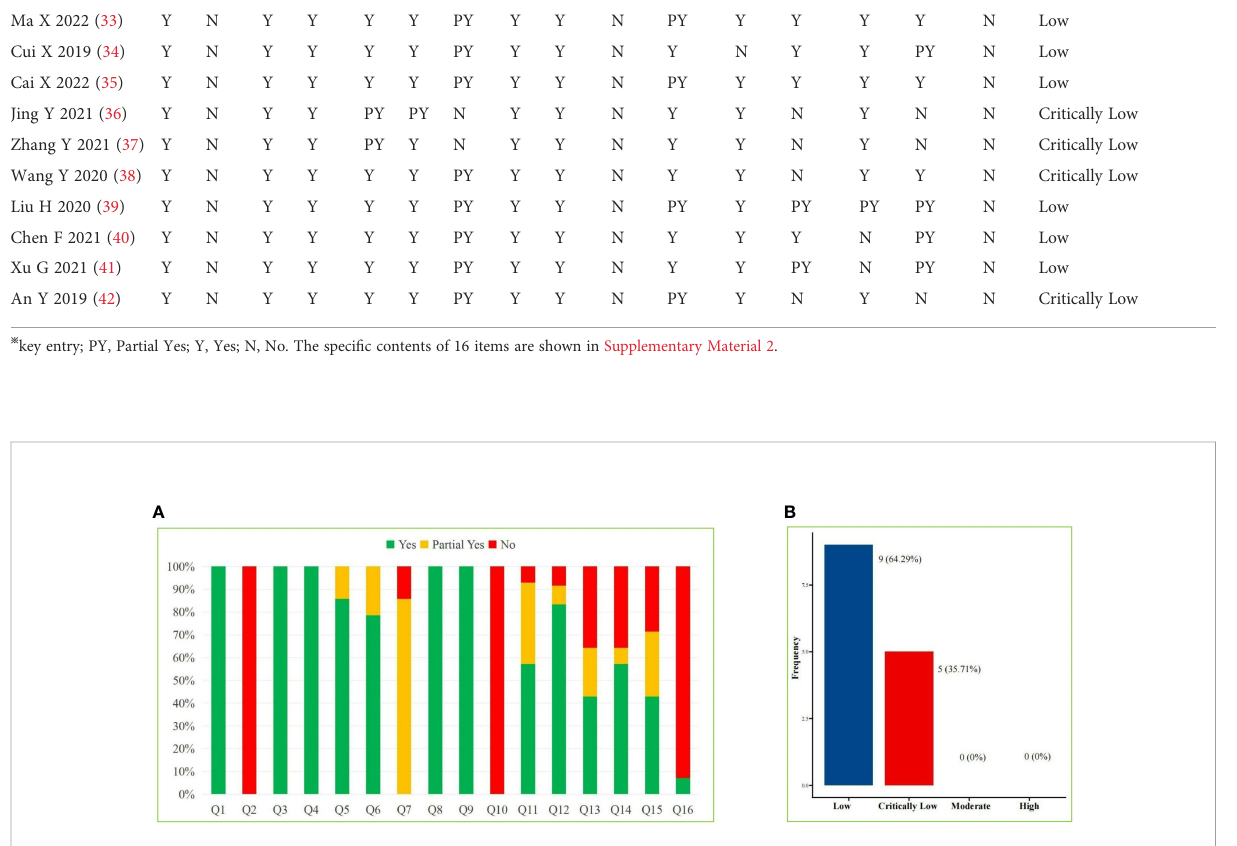
FIGURE 2 AMSTAR-2 Score Results. (A) Stacked bar chart of 16 items and (B) Straight bar graph of evidence